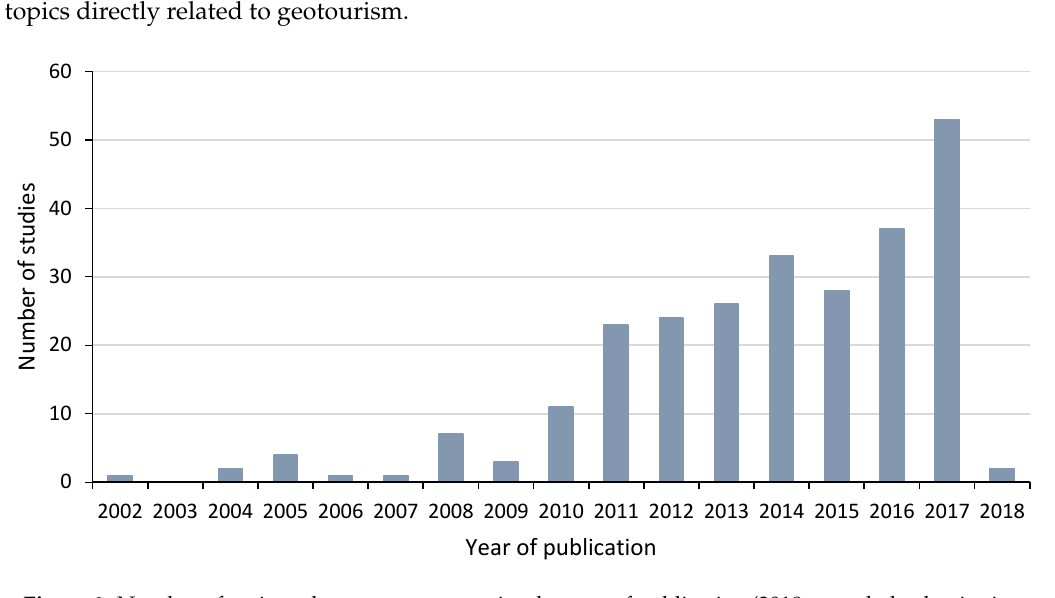
Figure 2. Number of reviewed papers on geotourism by year of publication (2018 extended to beginning of February).